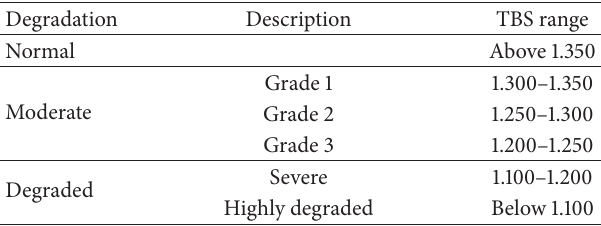
Table 2: Levels of degradation of trabecular structure according to